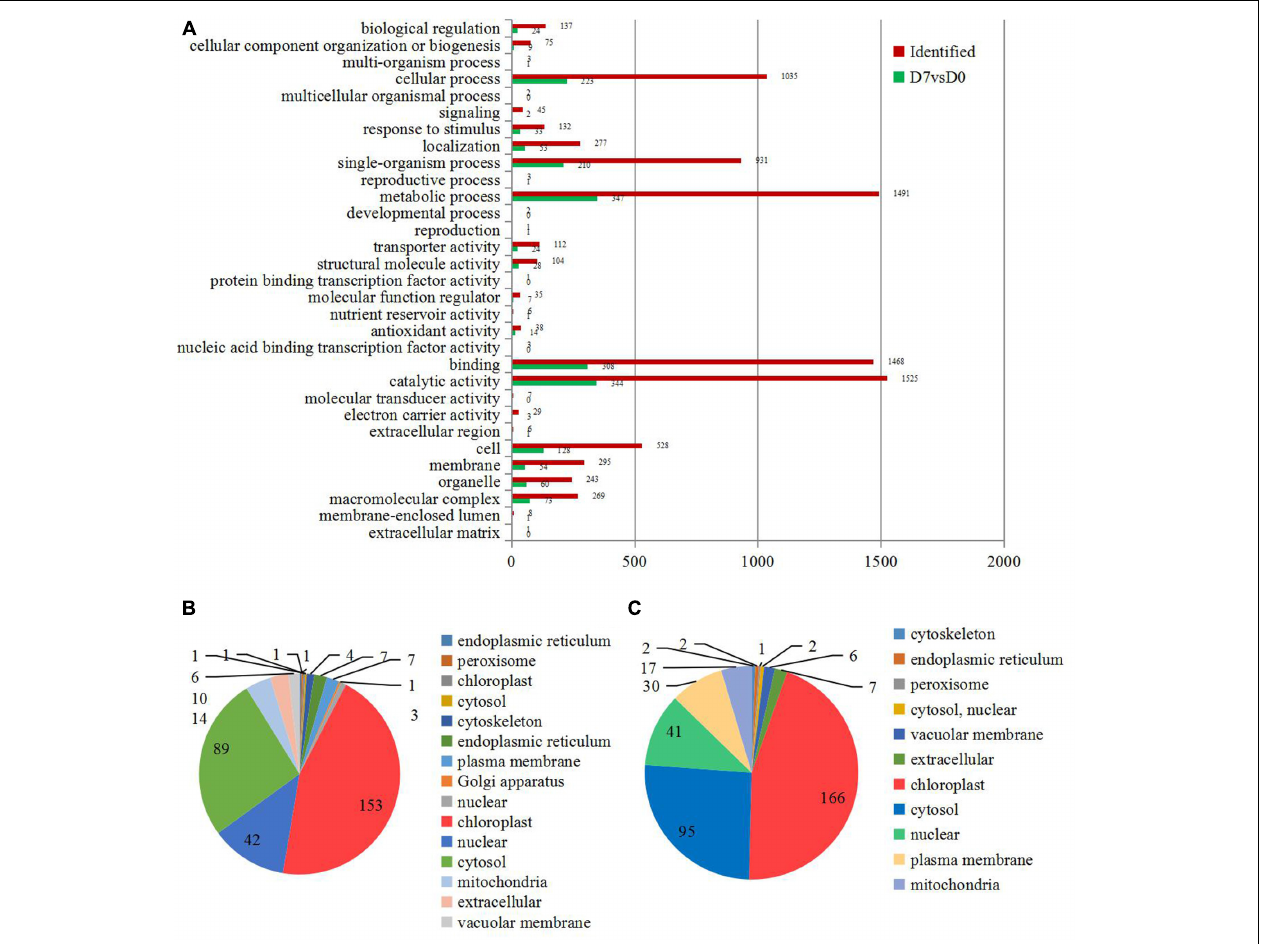
FIGURE 2 | The information of the concerning DEPs during the graft process. (A) All DEPs during the graft process were classified by GO terms based on their cellular component, molecular function, and biological process. Subcellular classify of up-regulated DEPs (B) and down-regulated DEPs (C)